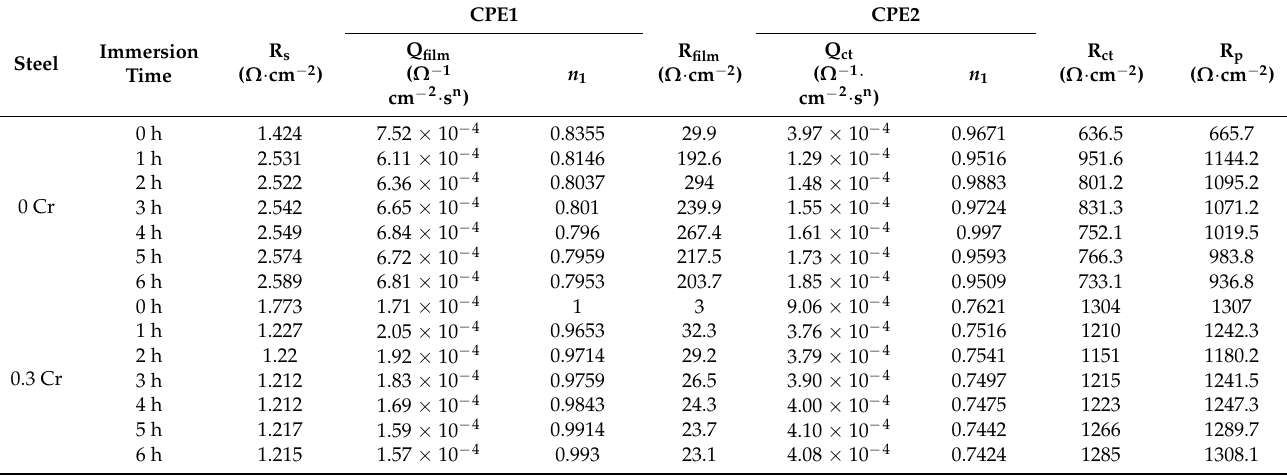
Table 3. Parameters from electrochemical impedance spectroscopy